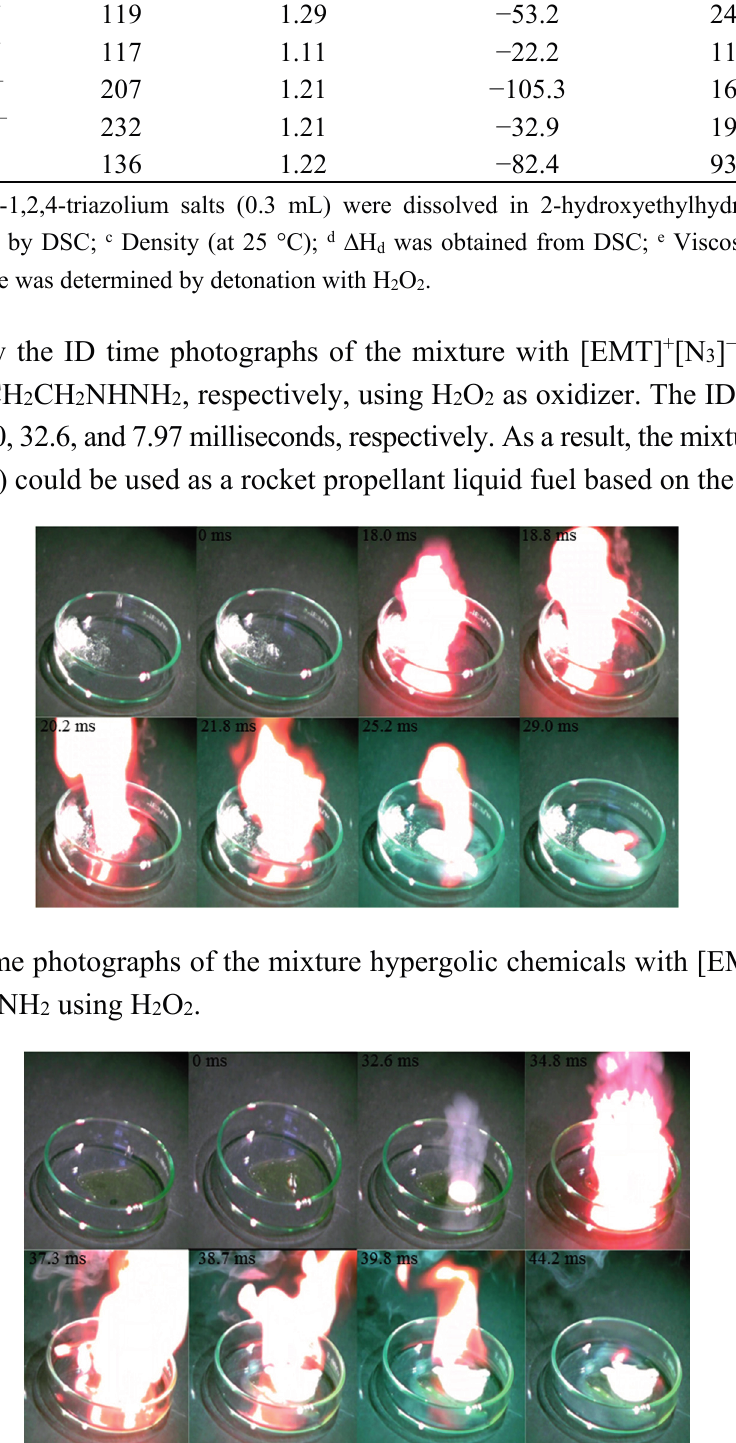
Figure 9. ID time photographs of the mixture hypergolic chemicals with [EMT] + [CN] − and HOCH 2 CH 2 NHNH 2 using H 2 O 2